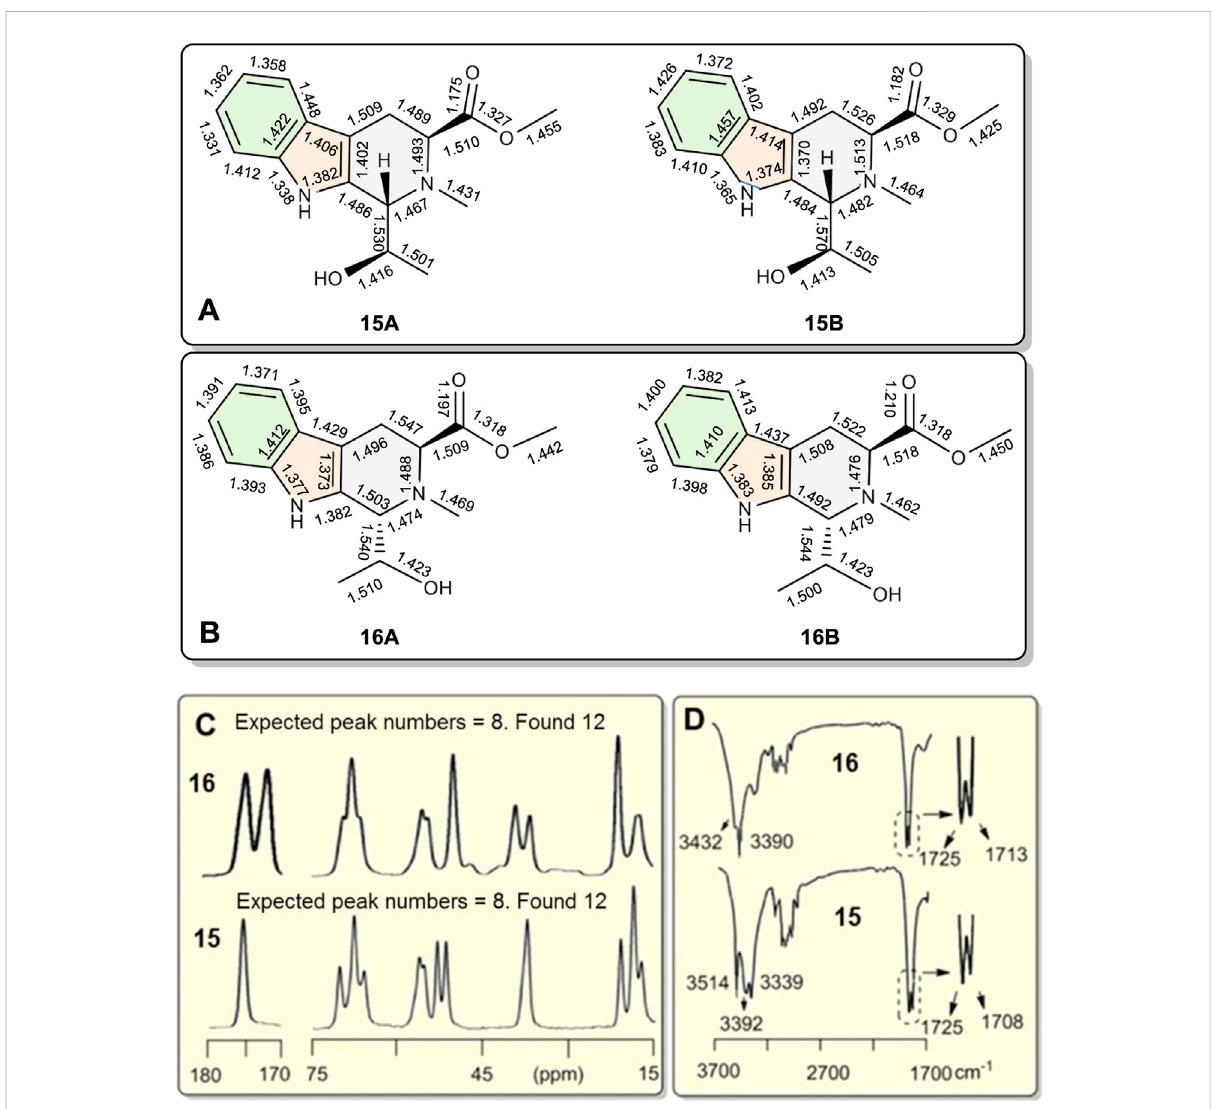
FIGURE 6 (A , B) The bond-length differences from single crystal X-ray diffractions of coexisting conformations 15A vs. 15B , and 16A vs. 16B , respectively. Conformations 15A and 16A are slightly smaller than 15B and 16B , respectively. (C) Partial 13 C CP-MAS NMR spectra of 15 and 16 in the solid state. A totalof12singletcarbonsignalswererecordedforboth 15 and 16 indicatingseparateanddistinctsolidstateNMRspectraexistfor 15A / 15B aswellas 16A / 16B. Eachhadjusteightcarbonresonances inthe15 – 75 ppmand170 – 180 ppmranges. (D) Partial IRspectraof 15 and 16 .Twostretching absorptions appeared in the corresponding C=O bonds in crystals of both 15 and 16